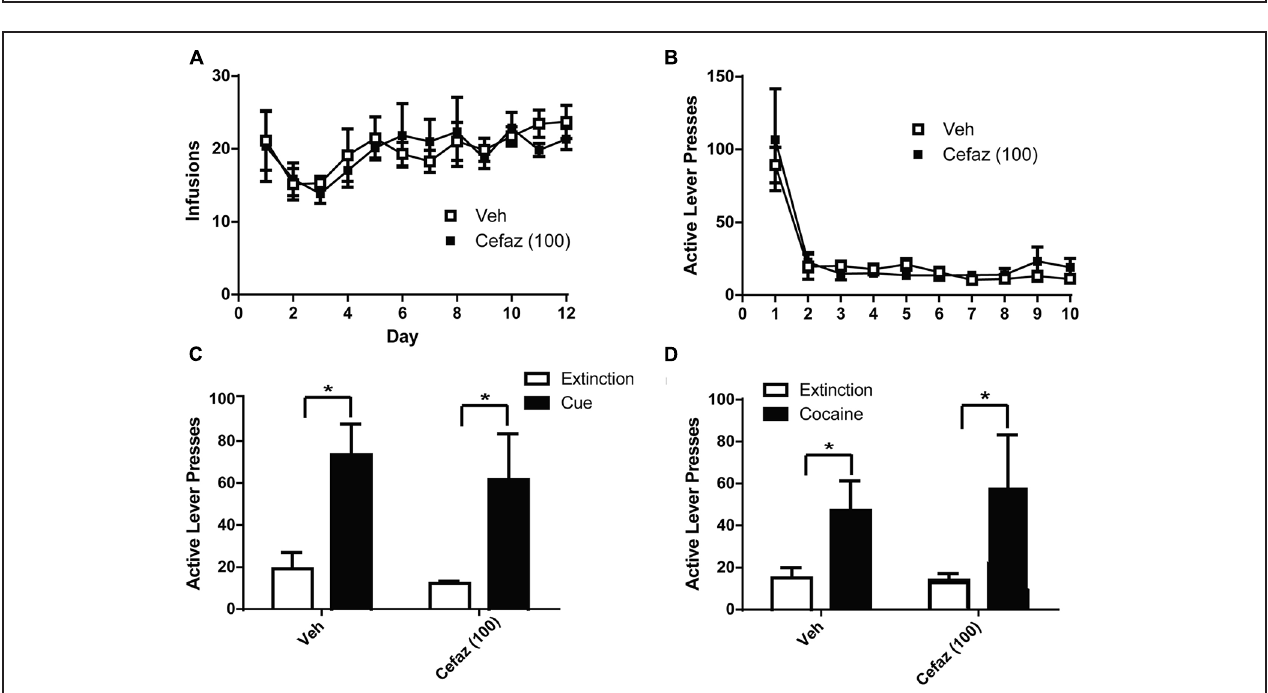
FIGURE 5 | Cefazolin did not attenuate cue- or cocaine-primed reinstatement of cocaine-seeking. (A) Animals later treated with vehicle or CEFAZ did not differ in the number of infusions attained during cocaine self-administration. (B) Vehicle- and CEFAZ-treated